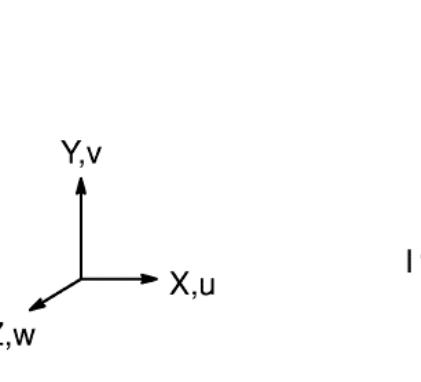
Figure 3. Solid element 187 [41].